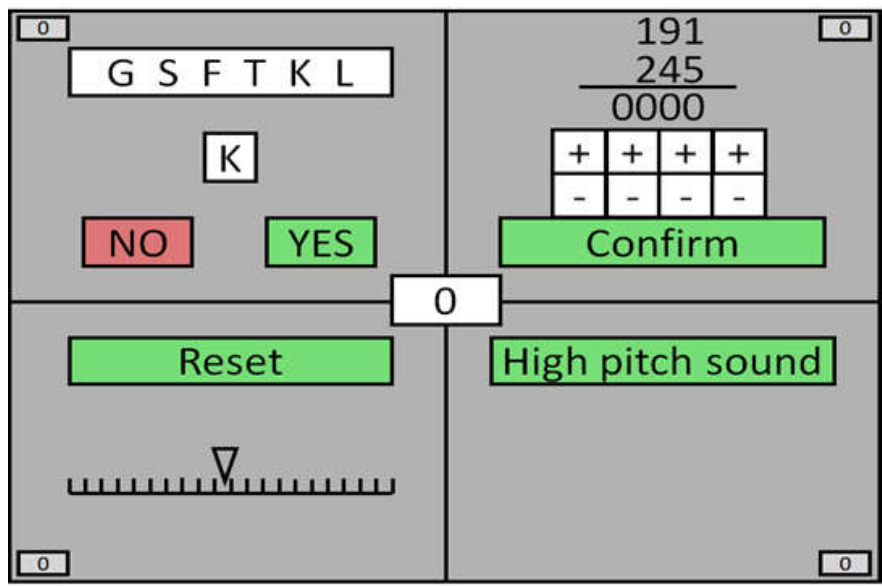
Figure 1. SynWin tasks (multitasking components): memory searching (upper left corner); arithme- tic task (upper right corner); visual monitoring (lower left corner); auditory monitoring (lower right corner).